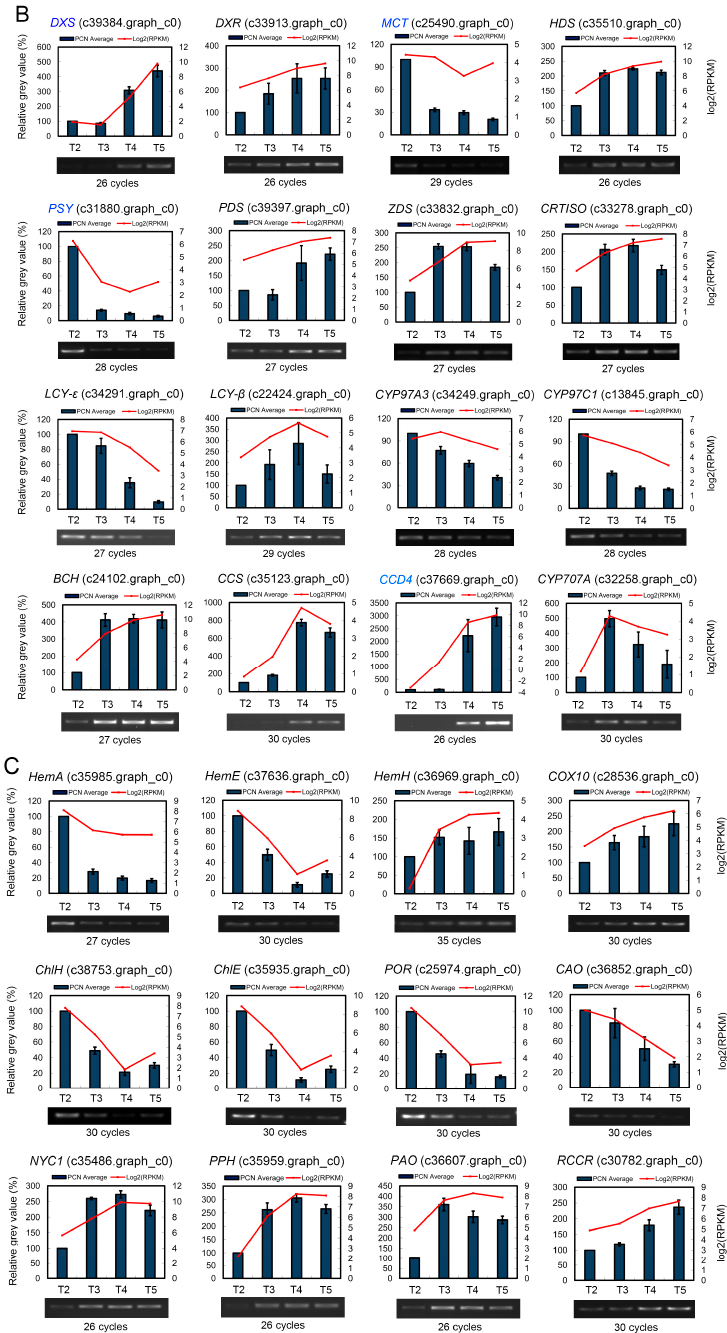
Figure 6. Semi-qRT-PCR validation of unigene expression patterns in flavonoids, carotenoids and chlorophyll metabolic pathways in tepals during pigmentation process: ( A ) expression of 16 unigenes of flavonoids metabolic pathway; ( B ) expression of 16 unigenes of carotenoids metabolic pathway; and ( C ) expression of 12 unigenes of chlorophyll metabolic pathway. Expression of all unigenes was confirmed in three biological repetitions with three technical replications. PCR cycles used to amplify specific genes were marked. The expression strength for each unigene was converted into grey value by software AlphaView. Relative expression level during four tepal pigmentation stages were recalculated after setting the grey value at T2 as 100%. Expression change trends of unigenes detected by semi-qRT-PCR were compared with the result of DGE-seq represented by RPKM values. The unigene GAPDH ( c28660.graph_c0 ) was used as an inner control.